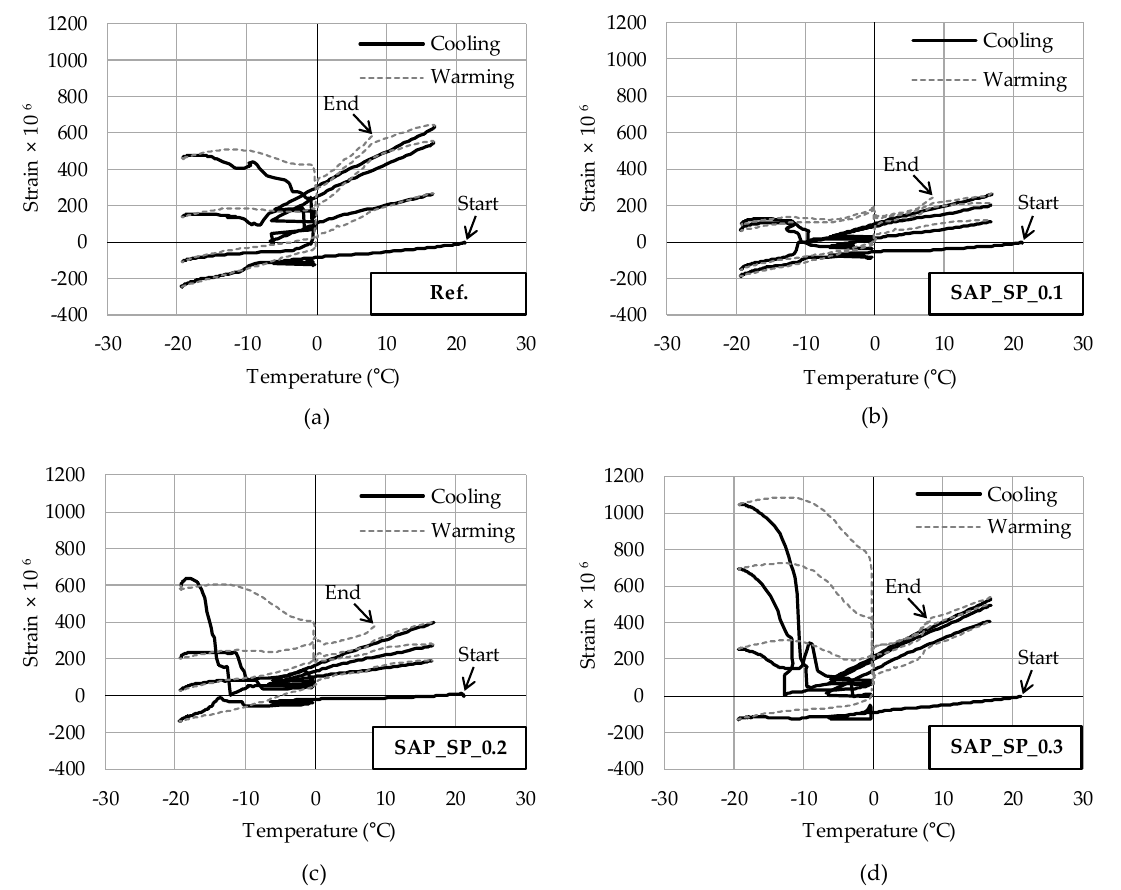
Table 4. Average peak points of the strains on three specimens for each series during the freezing phase of the fourth cycle.